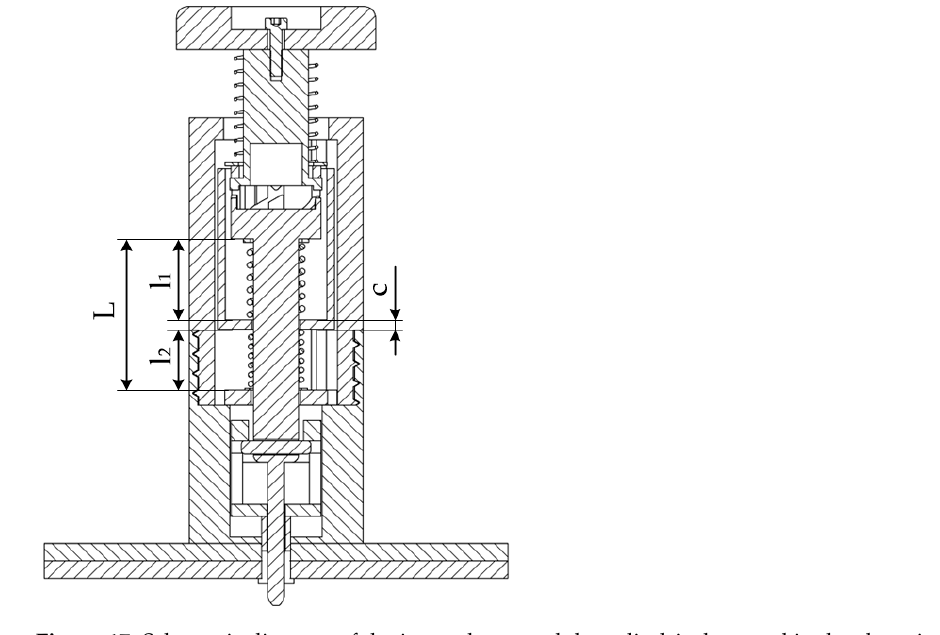
Figure 17. Schematic diagram of the inner sleeve and the cylindrical top rod in the clamping state. Because F 2 = F 3